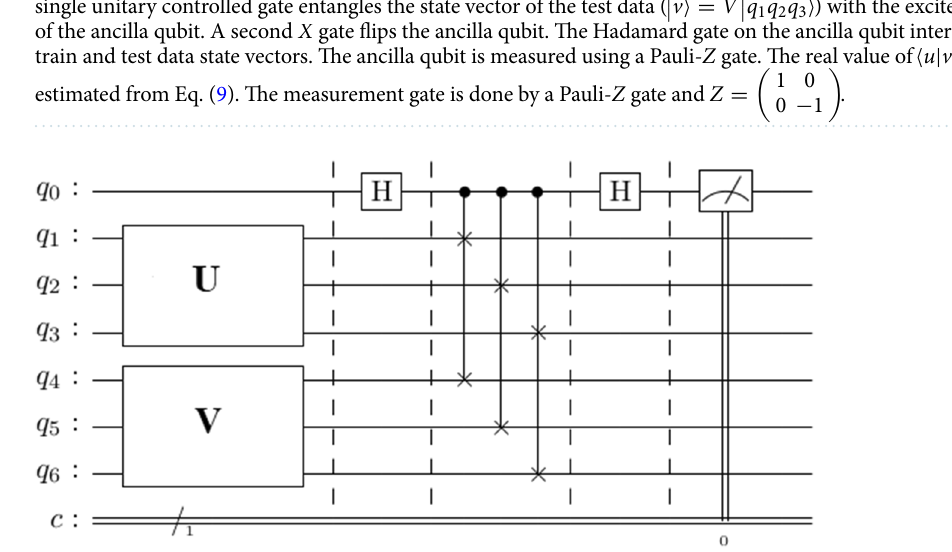
2 u v . The model circuits encode train and test data into quantum |� �| | v V q 4 q 5 q 6 . The Hadamard gate on the ancilla qubit ( q 0 ) generates a � = � (cid:31) (cid:31) u v v u and . The ancilla qubit on the | �| | �| � � 2 u v can be obtained from Eq. |� �| |